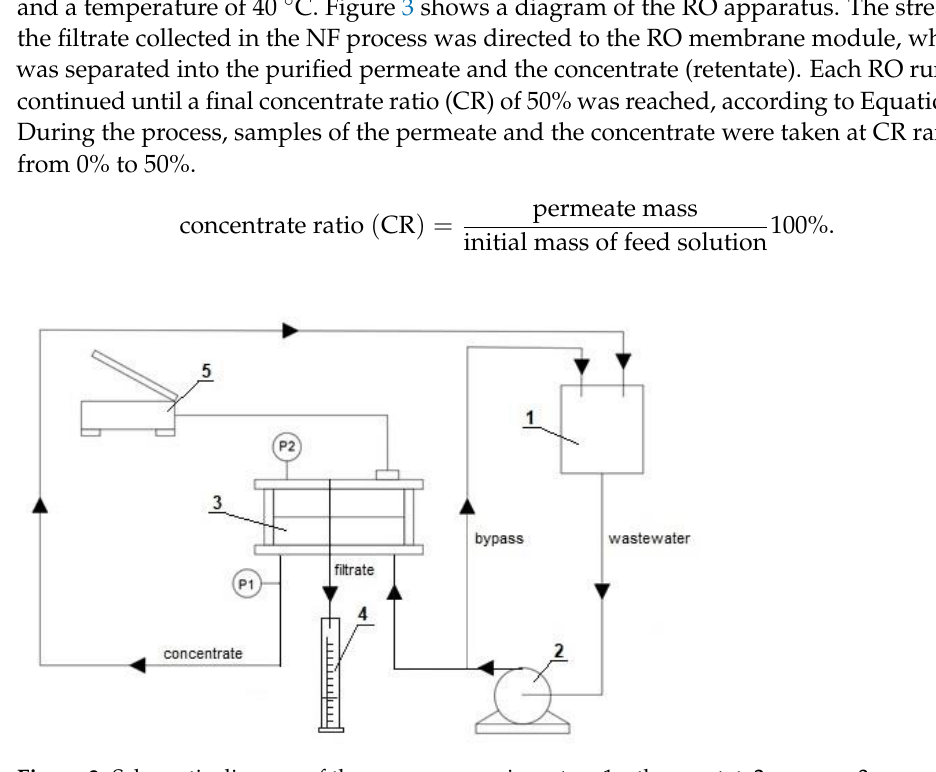
Figure 3. Schematic diagram of the reverse osmosis system:1 — thermostat; 2 — pump; 3 — membrane module; 4 — measuring cylinder; 5 — auxiliary pump; P1, P2 — manometers. module; 4—measuring cylinder; 5—auxiliary pump; P1,